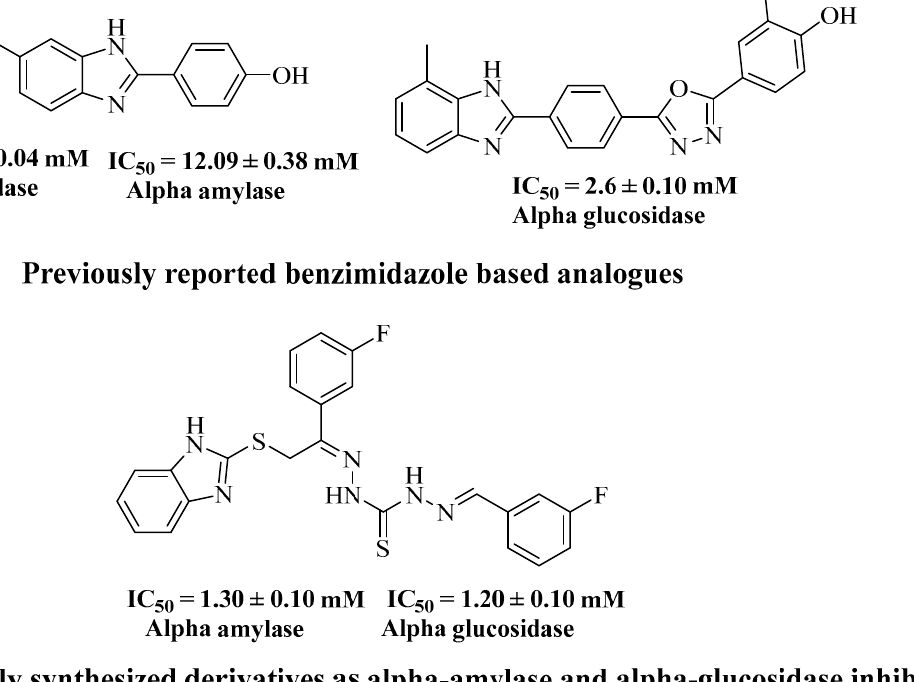
Figure 2. Rationale of the current study.